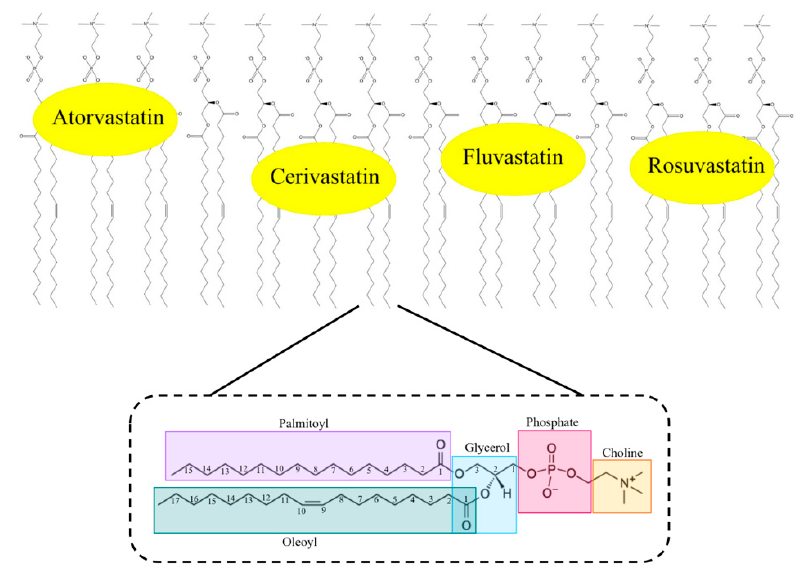
Figure 6. Schematic representation of the approximate binding locations of statins (atorvastatin, cerivastatin, fluvastatin, rosuvastatin) within POPC lipid bilayers. Magnified is a POPC lipid with labelled chemical moieties. Reprinted from Biochimica et Biophysica Acta (BBA)–Biomembranes, 1861, Galiullina et al., Interactions of statins with phospholipid bilayers studied by solid-state NMR spectroscopy, 10, [115] Copyright (2018), with permission from Elsevier.